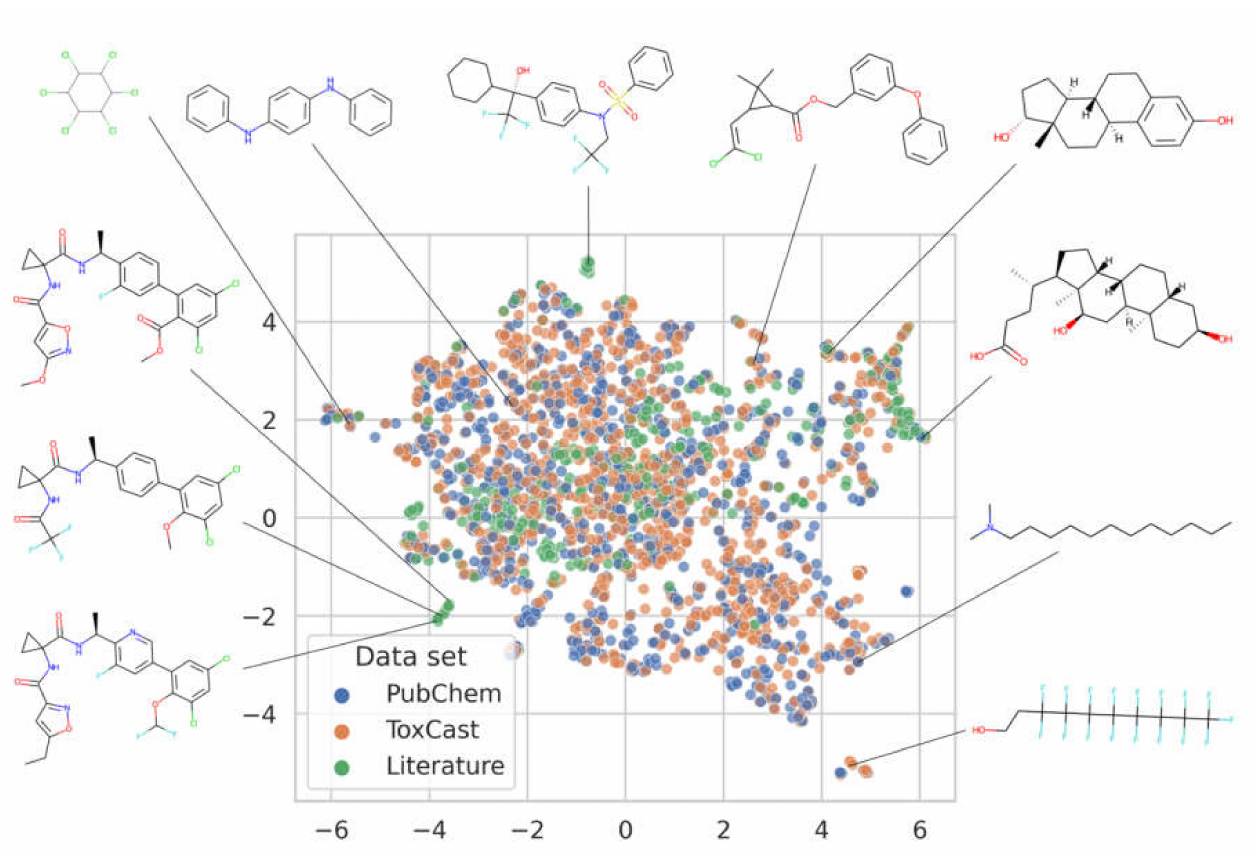
Figure 2. 2D embedding of the molecules contained in the PubChem, ToxCast, and literature PXR data sets. For almost every molecule (99%), all of its neighbors that have a Tanimoto similarity (based on Morgan fingerprints with a radius of 2 and a length of 2048 bits) greater than 0.7 are within a distance of 0.4 in the